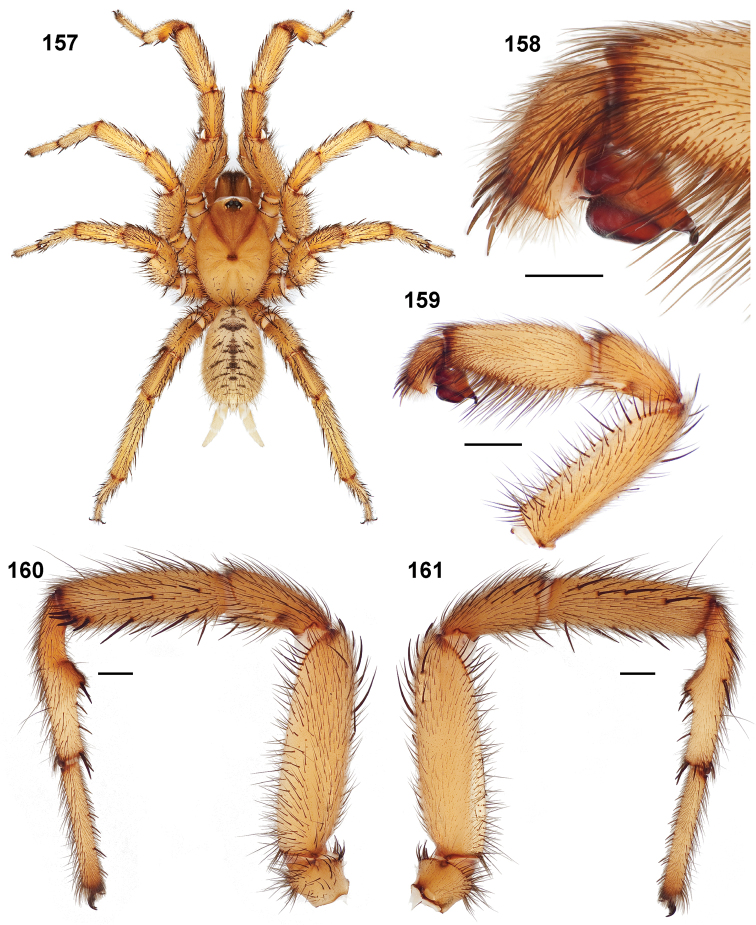
Aptostichus cabrillo sp. n. male holotype from San Diego Co. (AP1161). 157 habitus [806592]; scale bars = 1.0mm 158 retrolateral aspect, palpal bulb [806596] 159 retrolateral aspect, pedipalp [806713] 160, 161 leg I, retrolateral and prolateral aspect views [806600, 806598].